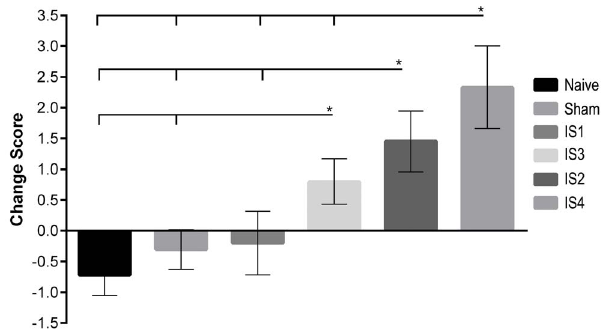
Figure 2. NSS-R for animals at day 1 post injury. Change scores between day 1 post injury and baseline were calculated. A gradual, but significant increase in the NSS-R scores were observed day 1 post injury with the increased severity of the injury within the mild spectrum. As expected, naı¨ve and sham groups did not show any increase in their NSS-R scores. No change was observed in the IS1 group. NSS-R score of IS2, IS3, and IS4 groups increased and was the highest among the IS4 group. * P value ,